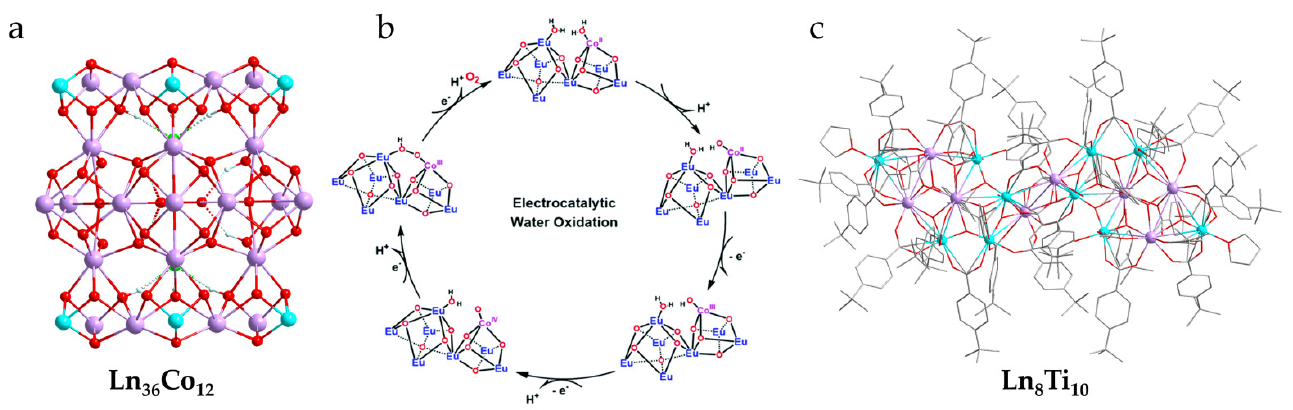
Figure 6. ( a ) The structure of Ln 36 Co 12 cluster core. ( b ) The proposed mechanism for water oxidation [44]. ( c ) The structure of Ln 8 Ti 10 [45]. Color legends: Ln, lavender; Co and Ti, turquoise; O, red; C, gray; N, blue; Cl, green. Adapted with permission from Ref. [44]. Copyright 2021, Royal Society of Chemistry.